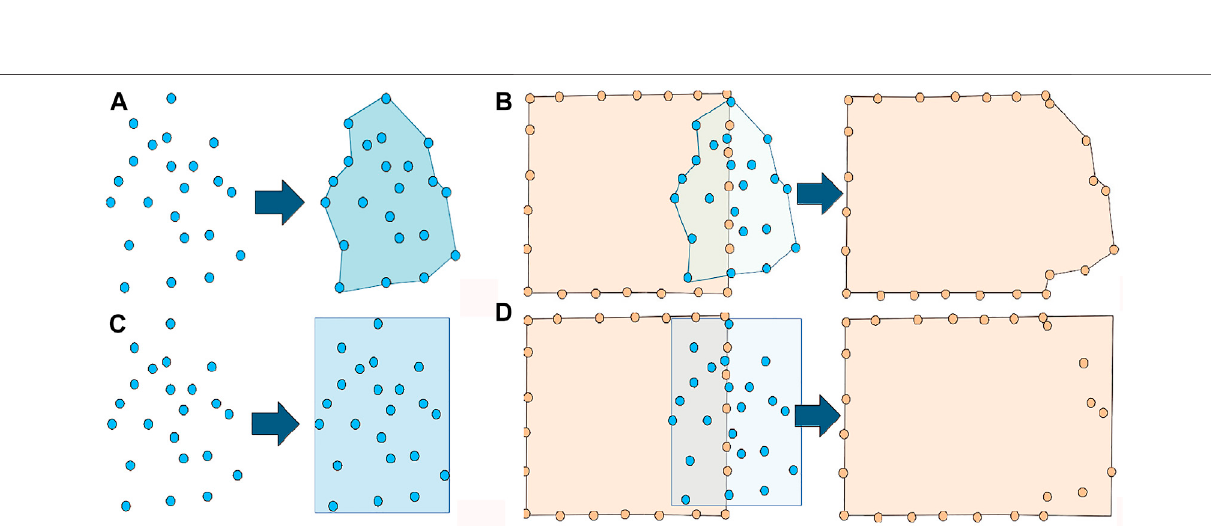
Frontiers in Virtual Reality |